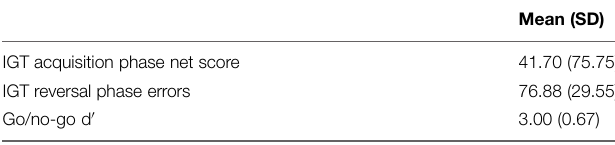
TABLE 1 | Mean performance on behavioral